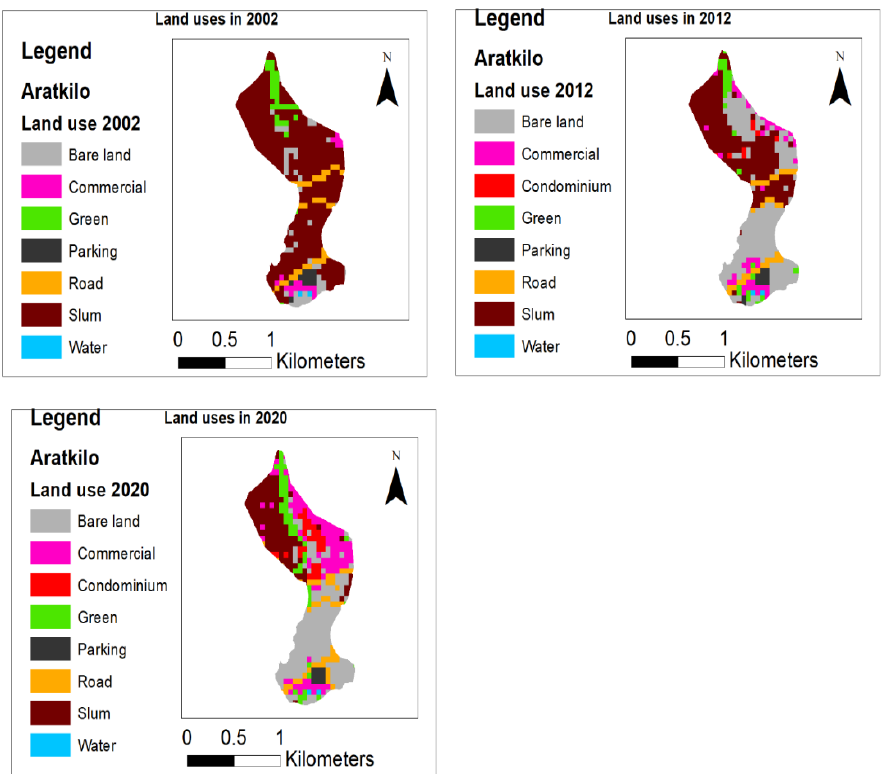
Figure 3. The land use composition for 2002, 2012, and 2020 in the urban core (Aratkilo neighborhood).